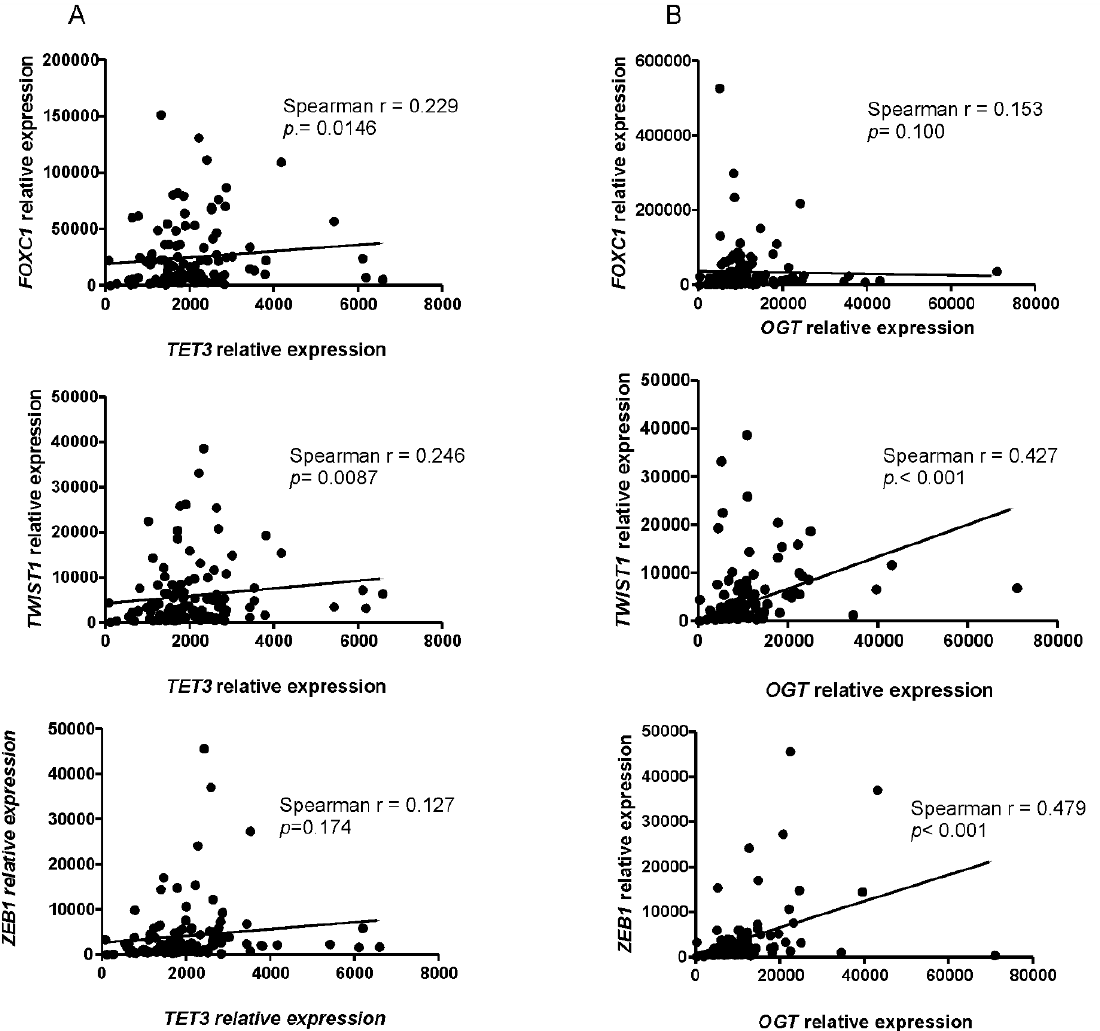
Figure 6. Correlations between gene expressions in endometrial cancer samples. Expression levels of TET3 , OGT , FOXC1 , TWIST1 , and ZEB1 in samples of endometrial cancers were evaluated by real-time quantitative PCR analysis with the HPRT1 gene applied as a reference. Spearman rank correlation analysis was performed to analyze the association of TET3 ( A ) or OGT ( B ) expression with FOXC1 , TWIST1 , and ZEB1 . The correlations were considered significant when p < 0.05.